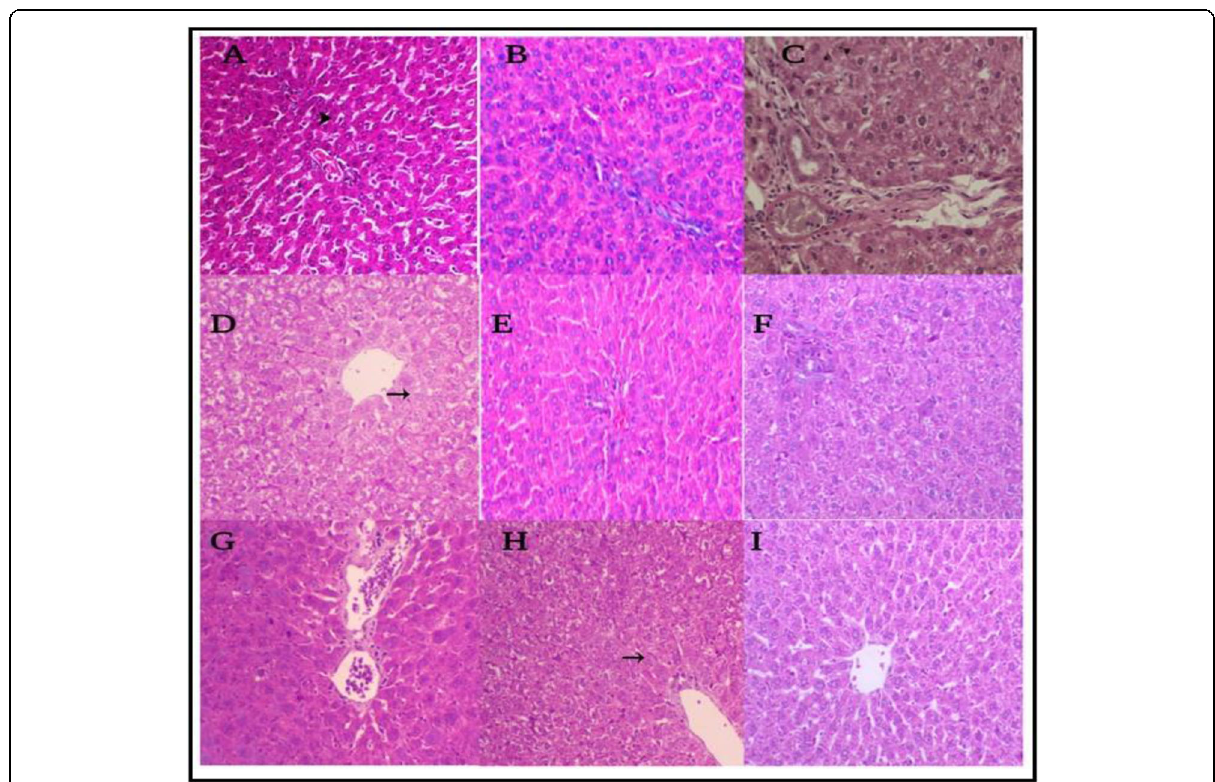
Fig. 11 A photomicrograph of the effects of CUR and SMX on CCl 4 -induced liver fibrosis in Swiss mice, H&E, × 200,400. a Normal hepatocytes around the portal area. b Normal liver structures. c Degenerative changes with an increased number of fibroblast and fibrosis. d Swelling of hepatocytes within the centrilobular area (arrow) in addition to a moderate degree of vacuolization of hepatocytes within the periportal area. e Normal liver structure. f Cloudy swelling and vacuolar degeneration of hepatocytes and mononuclear cells infiltration. g Normal liver structure. h Swelling and mild vacuolation of hepatocytes. i Normal liver